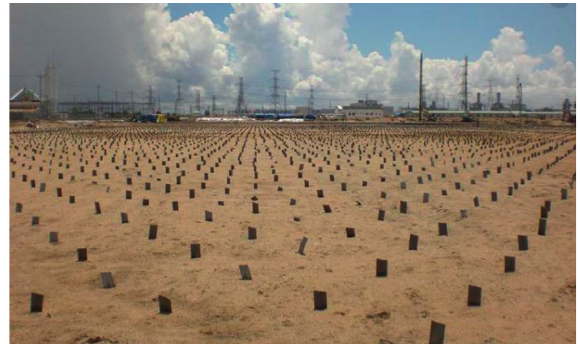
Figure 6: Plastic drainage plate